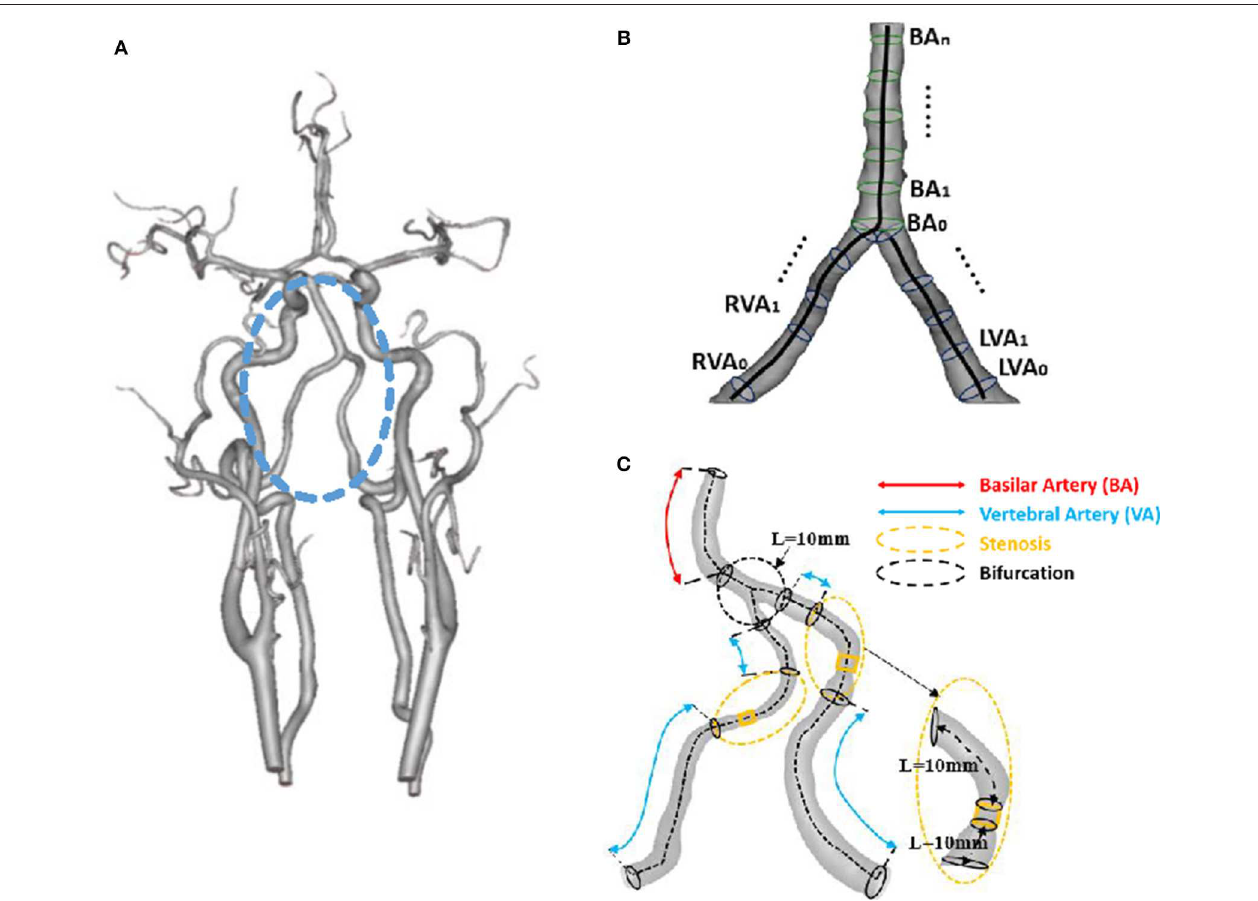
FIGURE 1 | (A) 3D geometrical model of cerebral arteries reconstructed from a patient CTA (The vertebrobasilar system inside the circle is comprised of left and right vertebral arteries and basilar artery); (B) Schematic representative of the best fit diameter D fit along centerlines of left and right vertebral arteries and basilar artery, where the best fit diameter is computed as twice the average radius between the point on the centerline and the contour forming the contour of the 3D object; and (C) Schematic representative of bifurcation and stenotic regions for determination of morphometric and hemodynamic parameters.